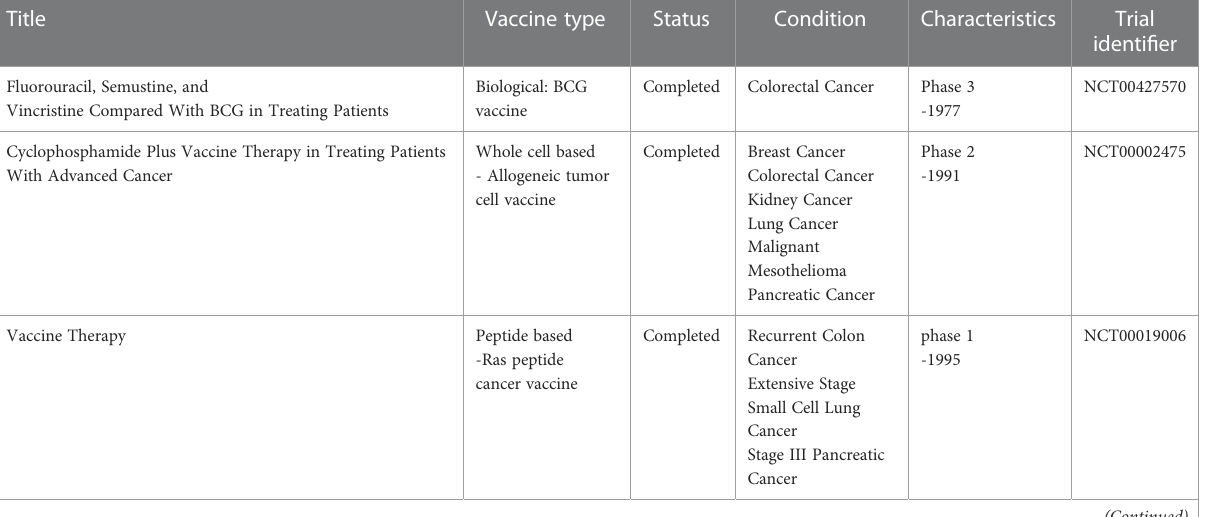
TABLE 3 The current registered clinical trials of vaccine therapy in colorectal